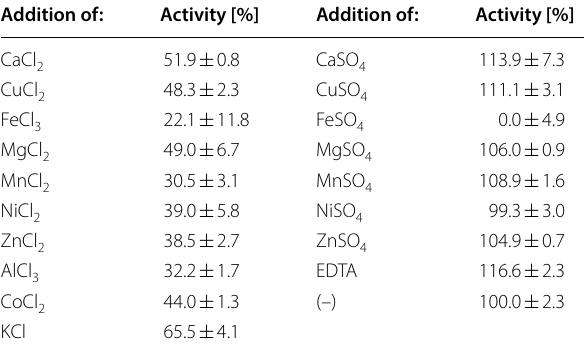
Table 3 Tvlcc5 activity in the presence of metal salts (1 mM)